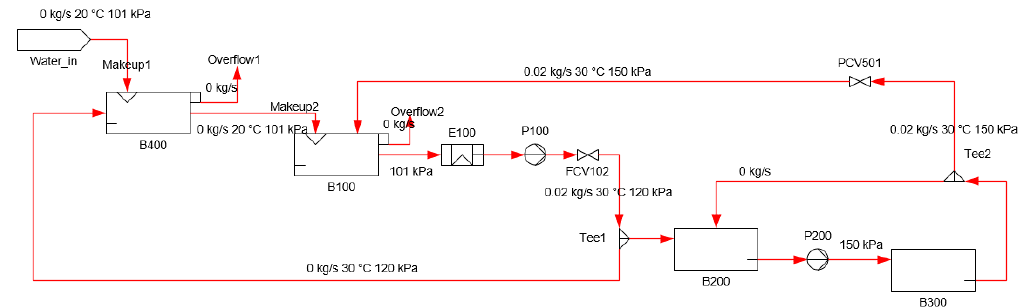
Figure 16. Simulations results of the case process.